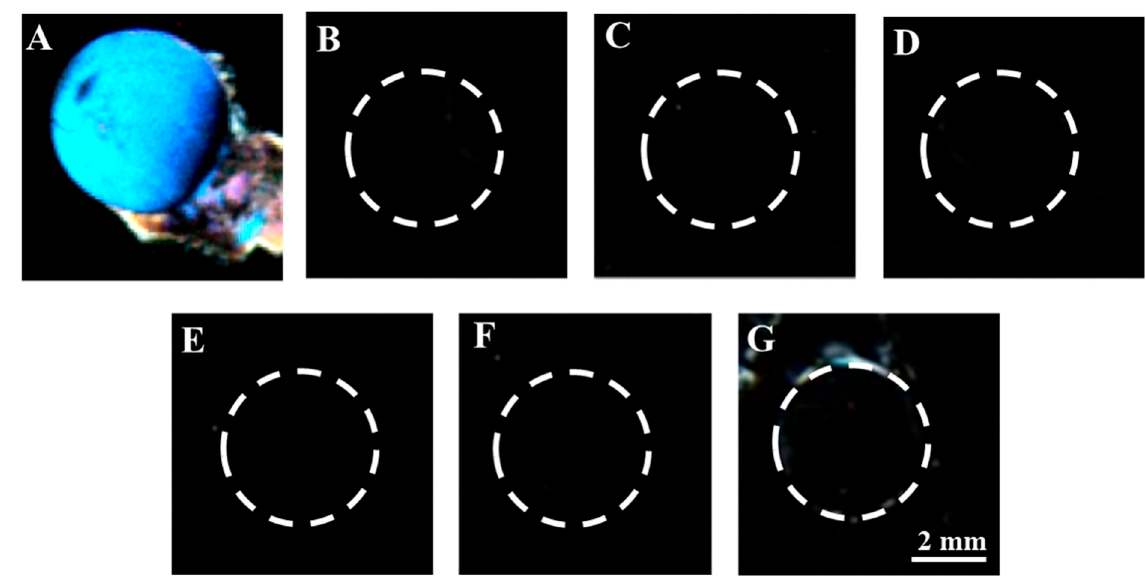
Figure 9. Optical images of LCs supported on B40t77 immobilized DMOAP decorated glass surfaces after treating with different proteins at concentration (8 µg/mL): ( A ) Gp-120, ( B ) BSA, ( C ) Hep A VP1, ( D ) IgG and ( E – G ) optical images with double concentration (16 µg/mL) of IgG, Hep A VP1 and BSA, respectively.